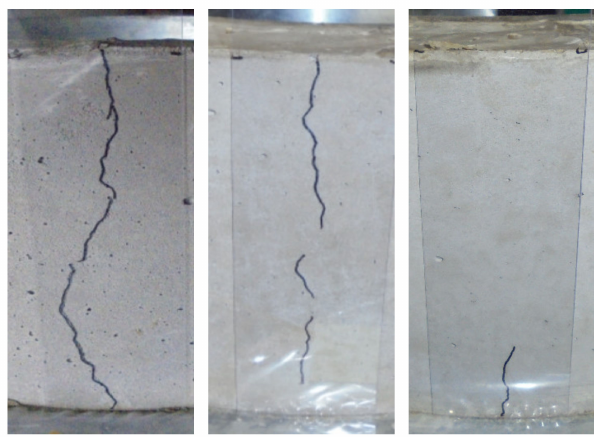
Figure 8. Examples of shrinkage cracking pattern.